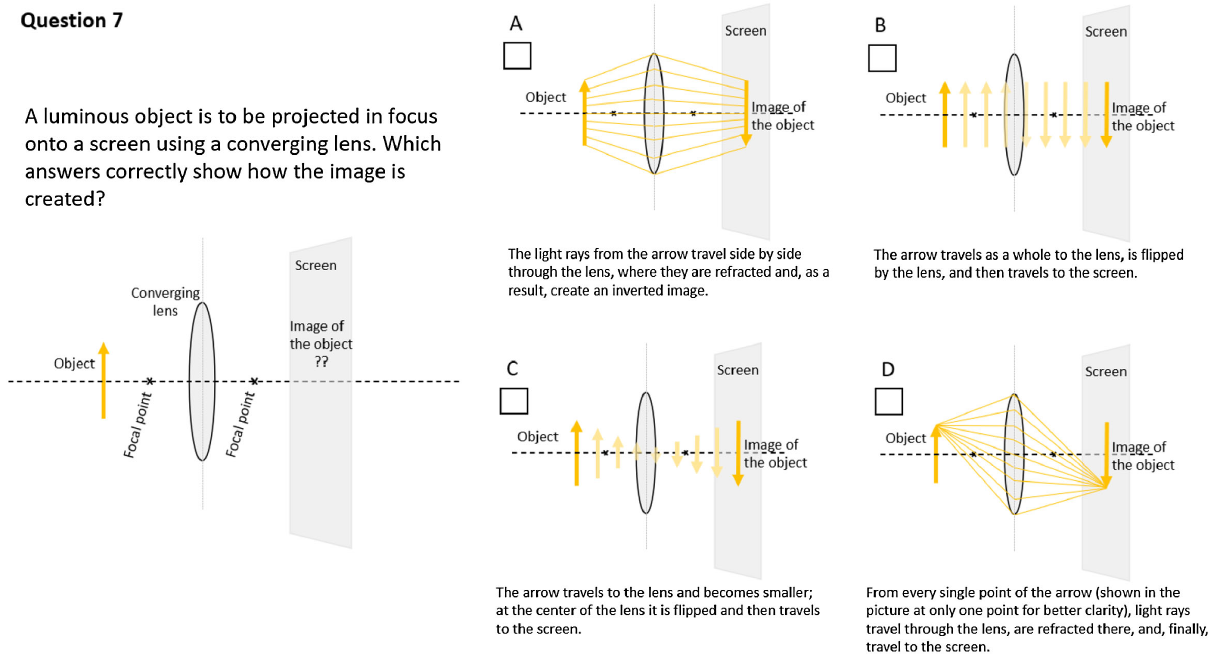
FIG. 3. Exemplary item of the ROC-CI (item Q7) with the default format: text and picture in both item stem and all answer